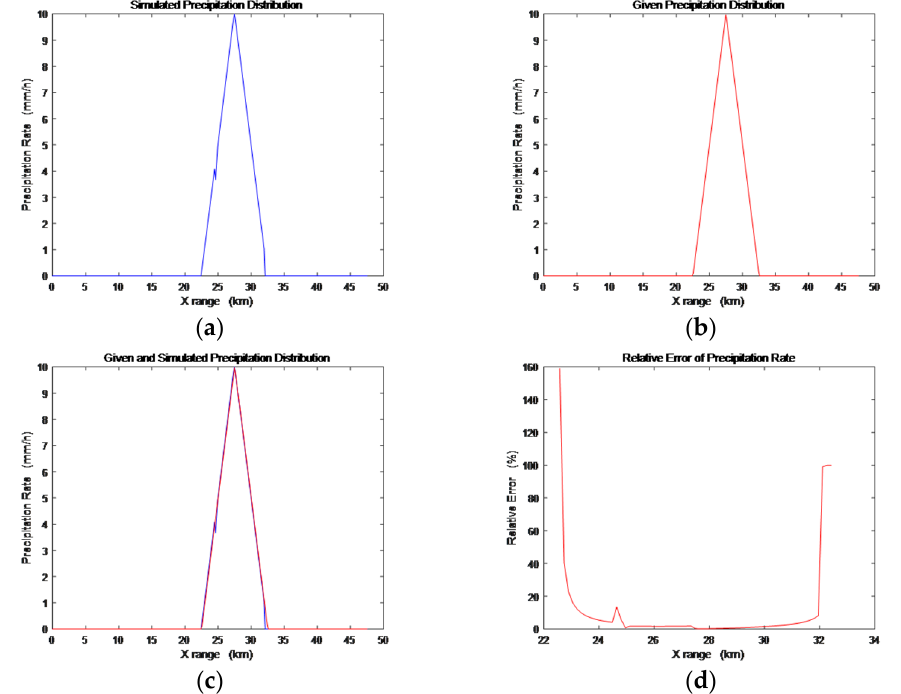
Figure 4. Triangular distribution diagrams for 𝑅(𝑥) = 10 mm/h . ( a ) Given precipitation distribu- tion; ( b ) Simulated precipitation distribution; ( c ) Given precipitation distribution and simulated pre- cipitation distribution; ( d ) Relative error between given and simulated result.